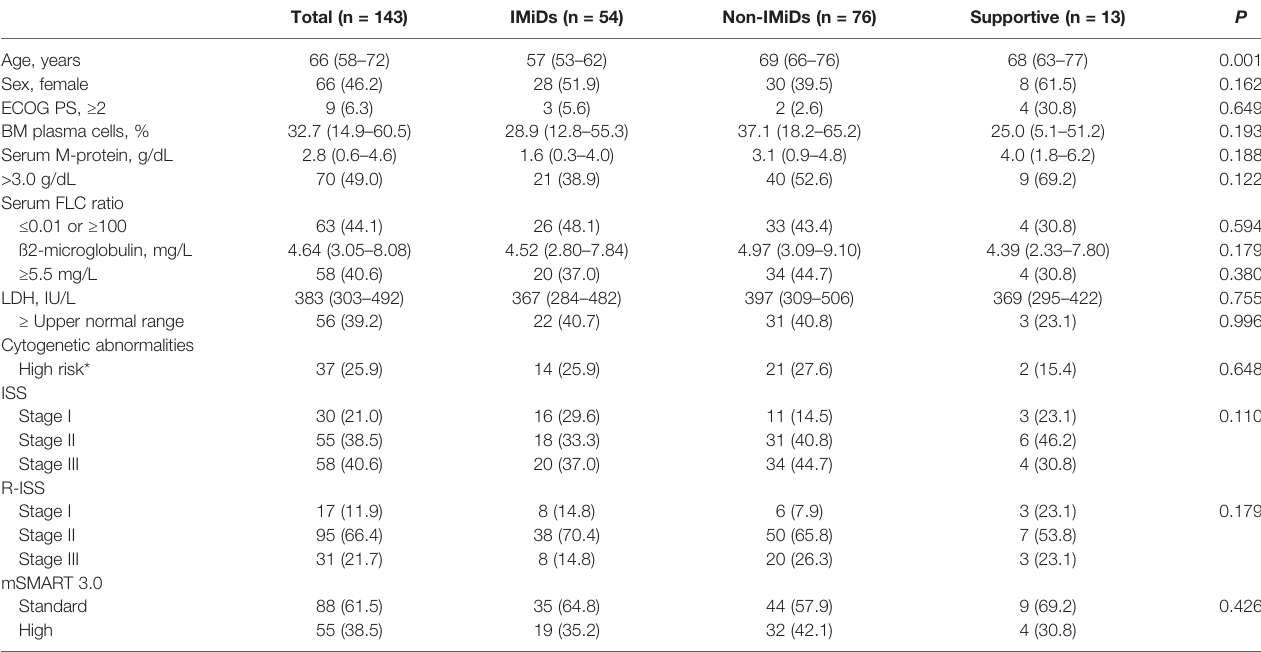
TABLE 1 | Baseline